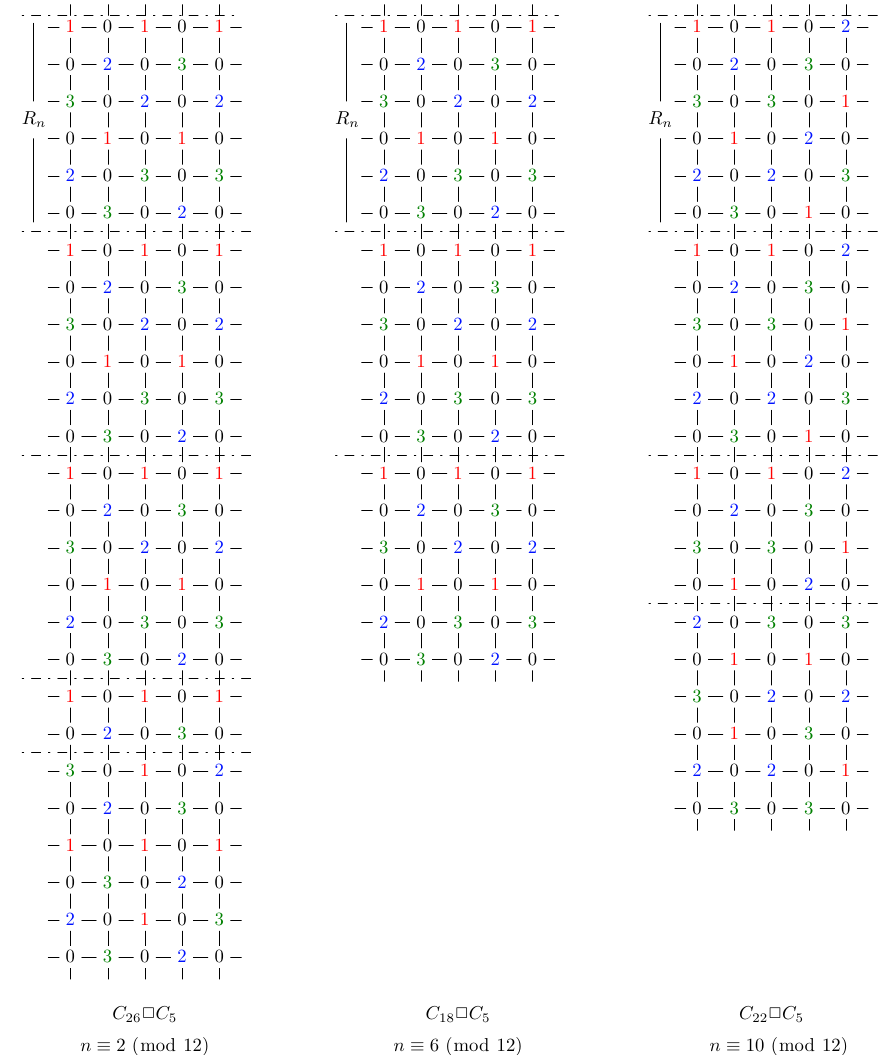
Figure 5. f on some C n 2 C 5 for n